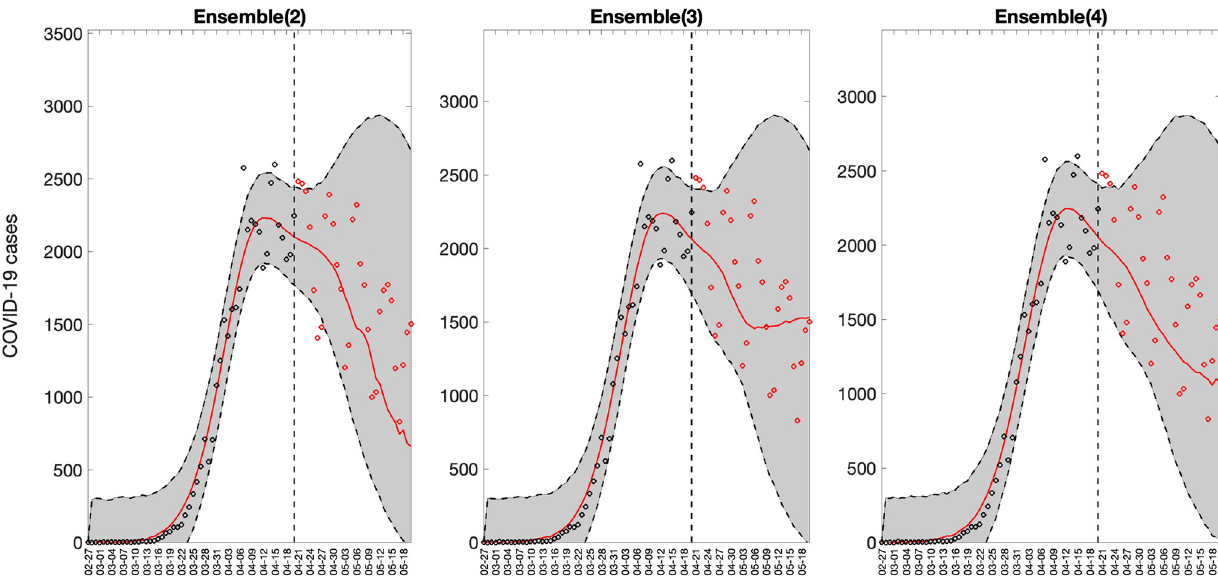
Fig 8. Representative sub-epidemic ensemble model forecasts (Ensemble(2), Ensemble(3), Ensemble(4)) of COVID-19 deaths in the USA from 20-April-2020 to 20-May-2022. Circles correspond to the data points. The model fits (solid line), and 95% prediction intervals (shaded area) are shown. Circles correspond to the data points. The vertical line indicates the start time of the